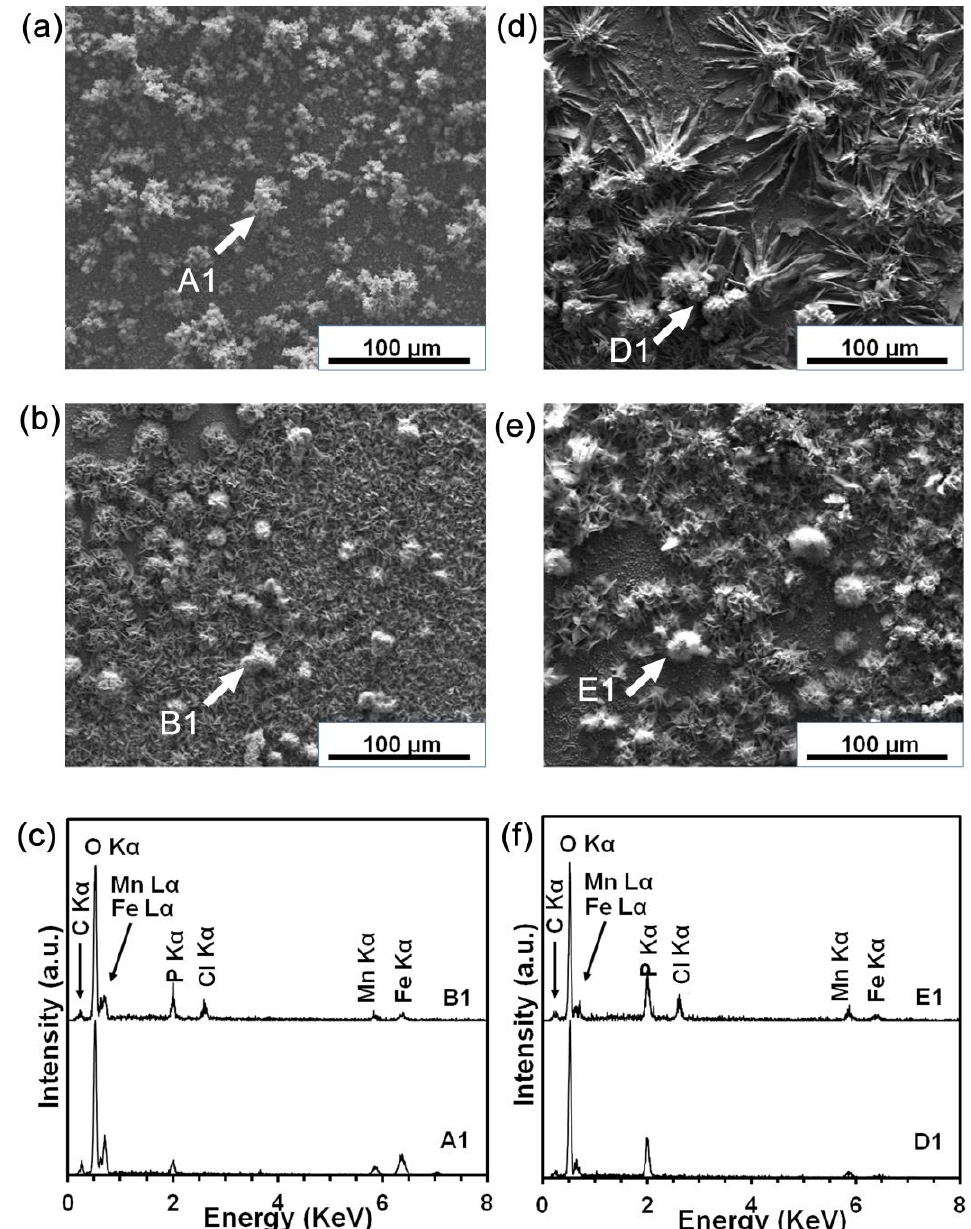
Figure 5. Surface morphology after the potentiodynamic polarization tests in MHBSS for ( a ) MP and ( b ) PT conditions; ( c ) EDS spectrum for A1 and B1. Surface morphology after the potentiodynamic polarization tests in DPBSS for ( d ) MP and ( e ) PT conditions; ( f ) EDS spectrum for D1 and E1.